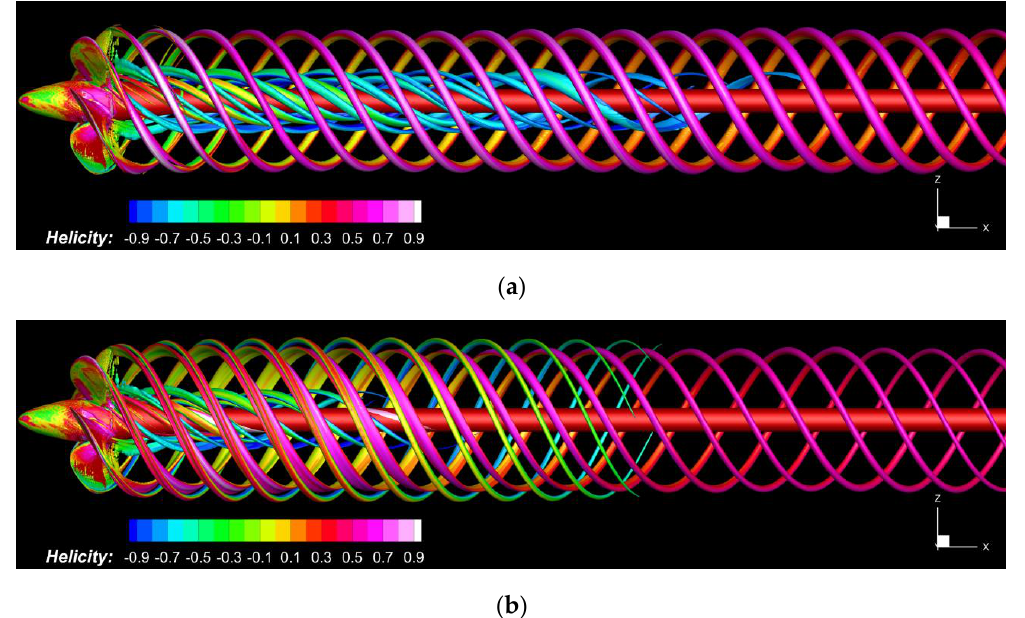
Figure 10. Comparison of the computed vortical structures released by the VP 1304 propeller. ( a ): 𝐽 = 1.4422 , ( b ): 𝐽 = 1.6021 .